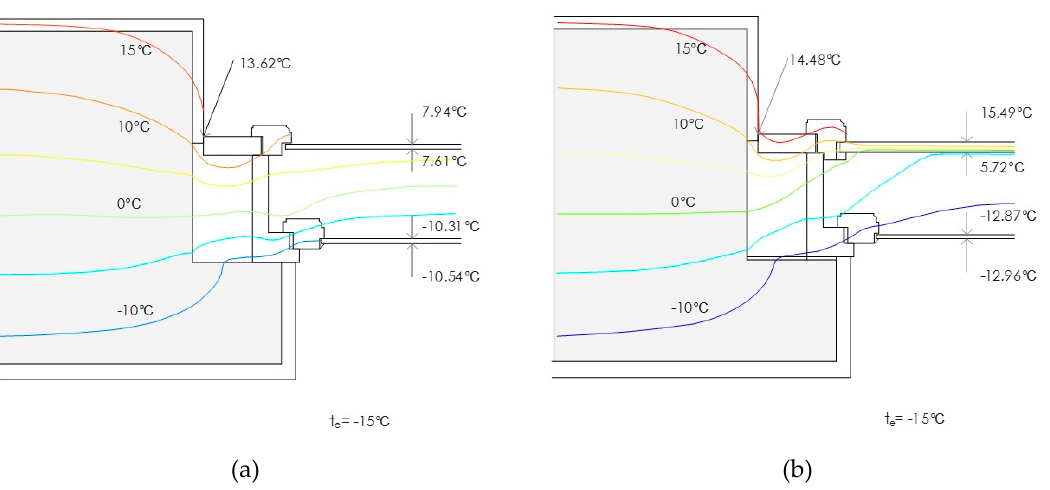
Figure 5. Isotherms of the original window ( a ) and the combined window ( b ).